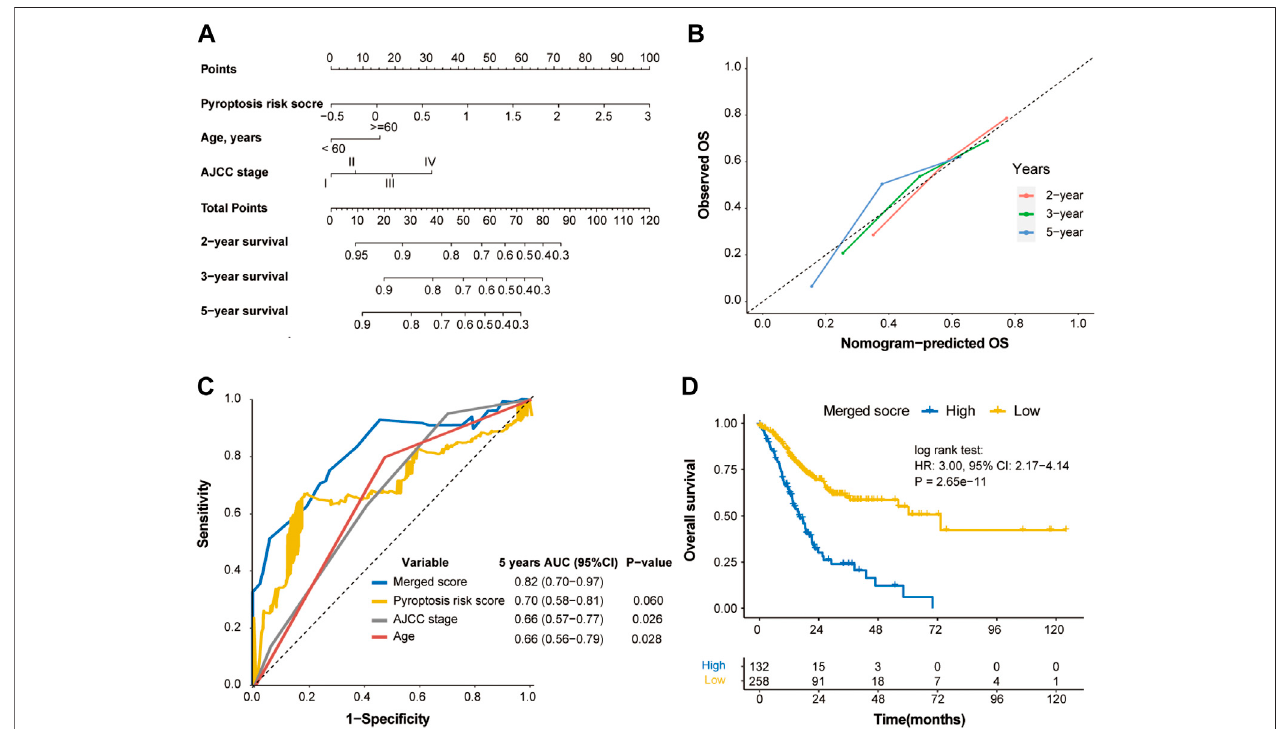
FIGURE 7 | Construction of merged risk score in the TCGA cohort. (A) A merged score was constructed by nomogram COX regression based on the pyroptosis riskscore,ageandTNMstageintheTCGAcohort. (B) Calibrationcurveofthenomogramregardingthepredictedandobservedsurvival. (C) Comparisonofthemerged score and other variables. (D) Kaplan-Meier curves of OS of high- and low-merged score. OS, overall survival.